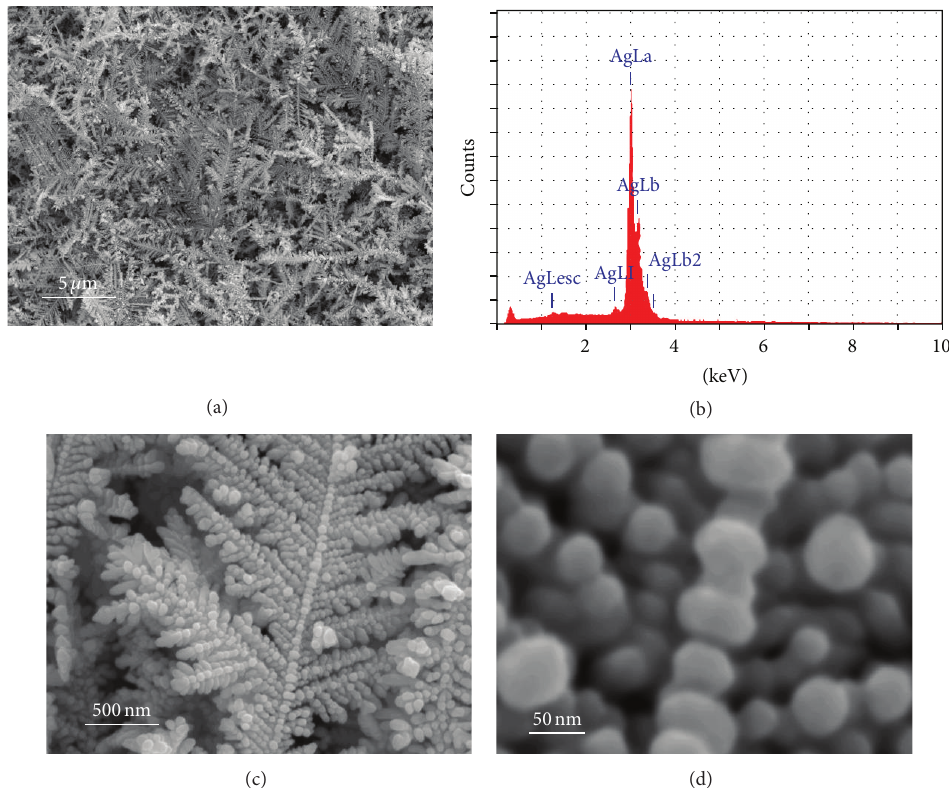
Figure 2: The SEM micrograph of Ag nanostructure electrochemically deposited in 0.2 mM Ag 2 SO 4 with the overpotential of − 0.25 V: (a) Low magnification, (b) EDX result, (c) high magnification, and (d) ultra-high magnification.